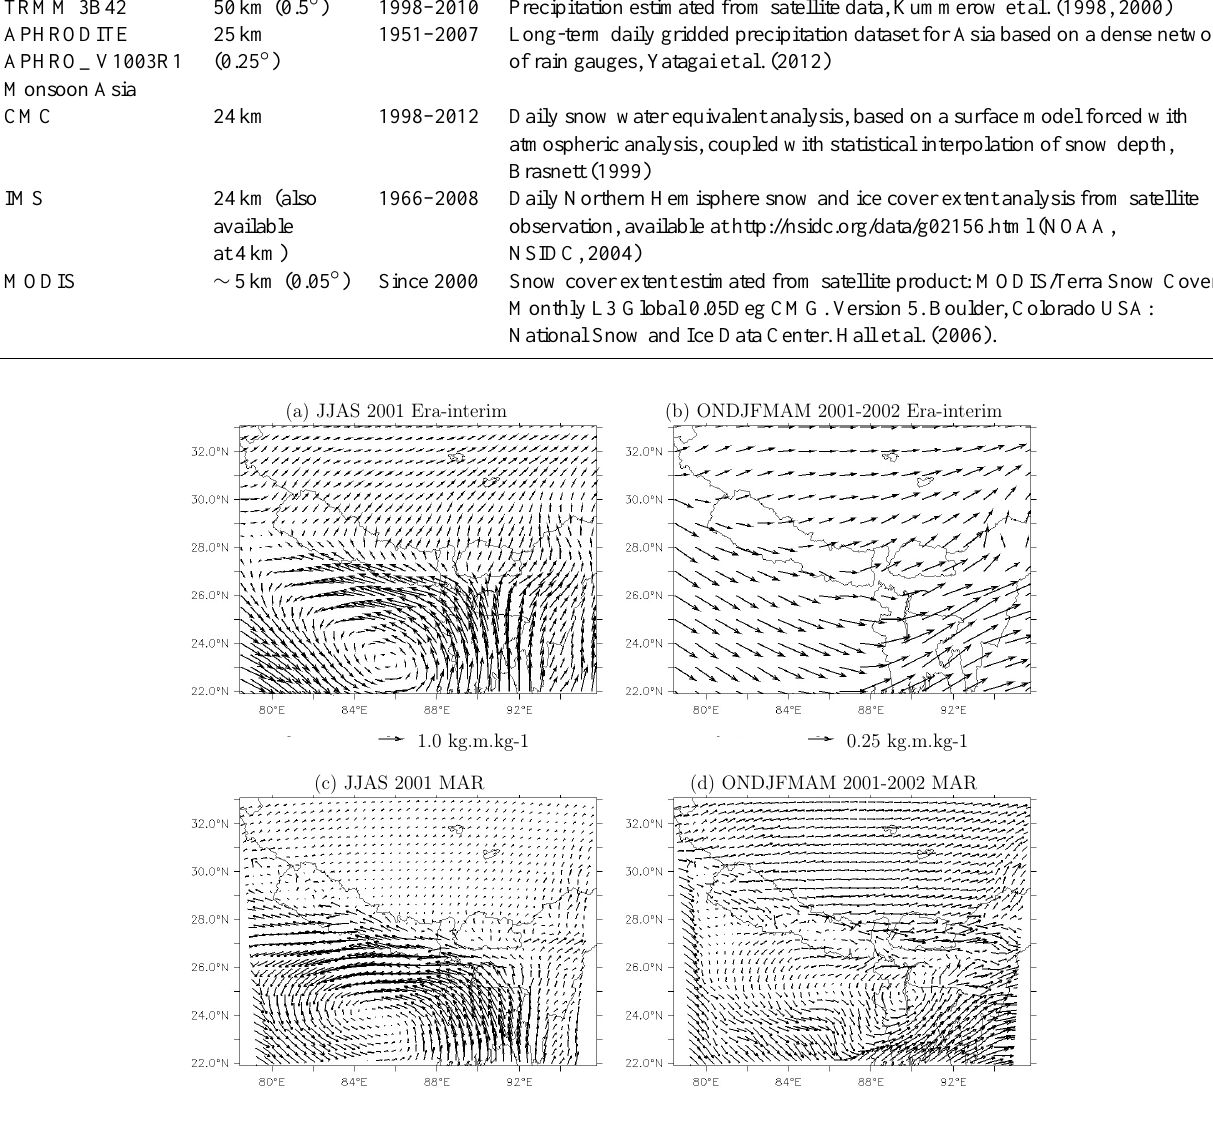
Fig. 1. Moisture flux (kgmkg − 1 s − 1 ) defined as wind velocity multiplied by specific humidity: estimated from the ERA-INTERIM during (a) monsoon (JJAS) 2001, (b) extra-monsoon period (ONDJFMAM) 2001–2002, and simulated with MAR during (c) monsoon (JJAS) 2001 and (d) extra-monsoon period (ONDJFMAM)